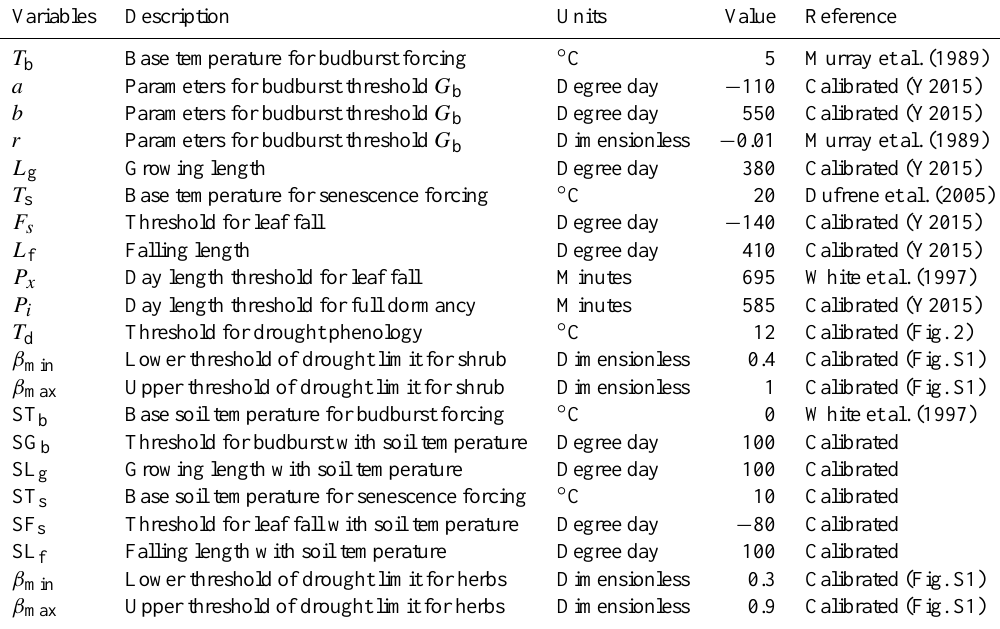
Table 2. Phenological parameters for the vegetation model. Variables Description Units Value Reference T b Base temperature for budburst forcing ◦ C Murray et al. (1989) Parameters for budburst threshold G b Degree day − 110 Calibrated (Y2015) Parameters for budburst threshold G b Degree day Parameters for budburst threshold G b Dimensionless